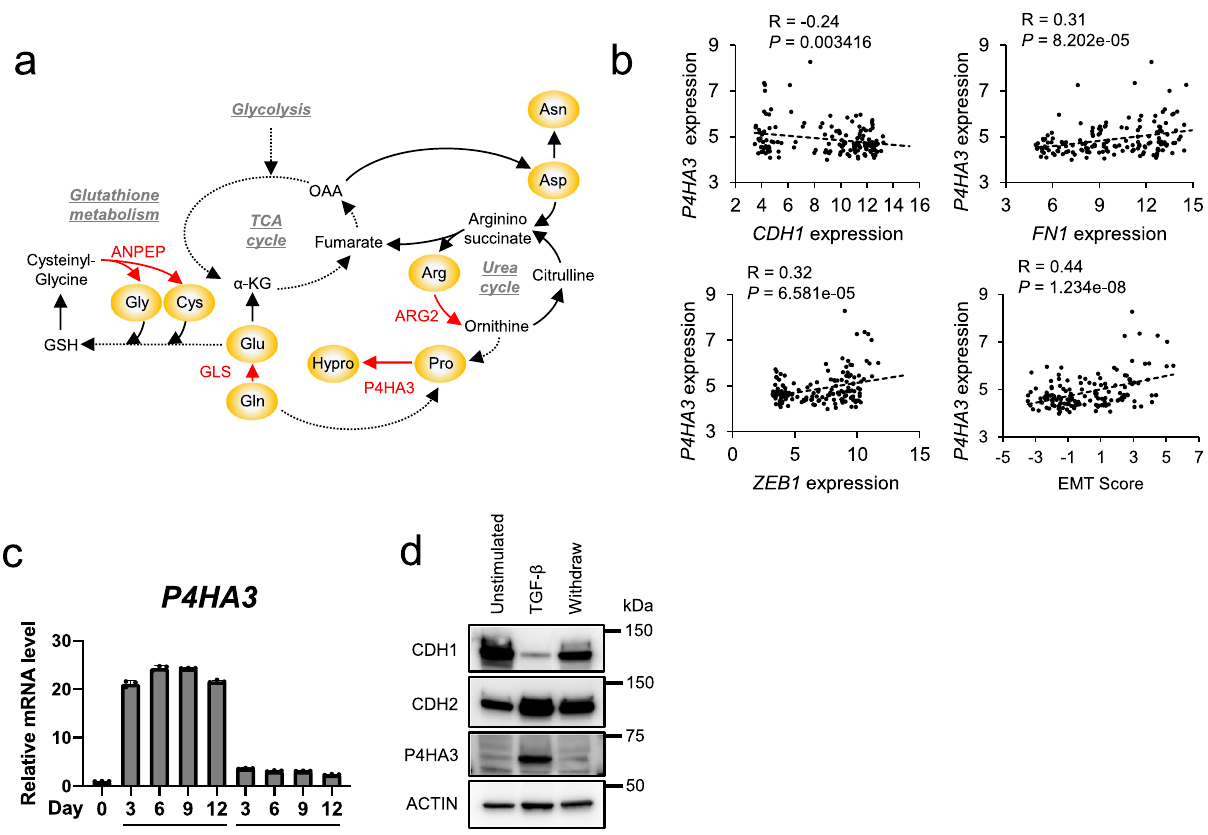
Fig. 4 Identi fi cation of P4HA3 by integrated metabolomic and transcriptomic analysis. a Metabolic reactions of ARG2, ANPEP, GLS, and P4HA3. b Correlations between EMT markers and P4HA3 mRNA expression in non-small cell lung cancer (NSCLC) cell lines in the Cancer Cell Line Encyclopedia (CCLE) dataset. EMT scores were calculated based on the expression of the reported 76 genes as an EMT marker in NSCLC. c Expression of P4HA3 during TGF- β -stimulation and withdrawal. A549 cells were stimulated with TGF β (2 ng/mL) for the indicated number of days (marked TGF- β ), and mRNA level of P4HA3 was measured by real-time PCR. Values are presented as the mean ± SD from triplicate samples. d Protein levels of EMT markers (CDH1 and CDH2) and P4HA3 in A549 cells. A549 cells were stimulated with TGF- β (5 ng/mL) for 3 days (marked TGF- β ) and then cultured in normal growth medium without TGF- β for 3 days (marked Withdraw). Actin was used as a loading control for western blot